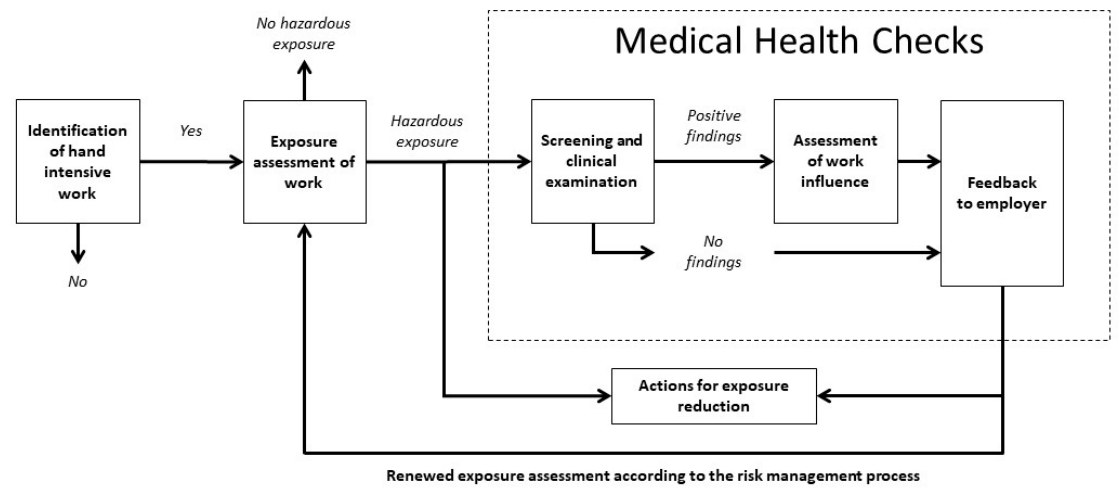
Figure 1. The work process model for the execution of occupational health surveillance for workers exposed to hand- intensive work (HIW)-model. The model interconnects exposure assessments with medical health checks.